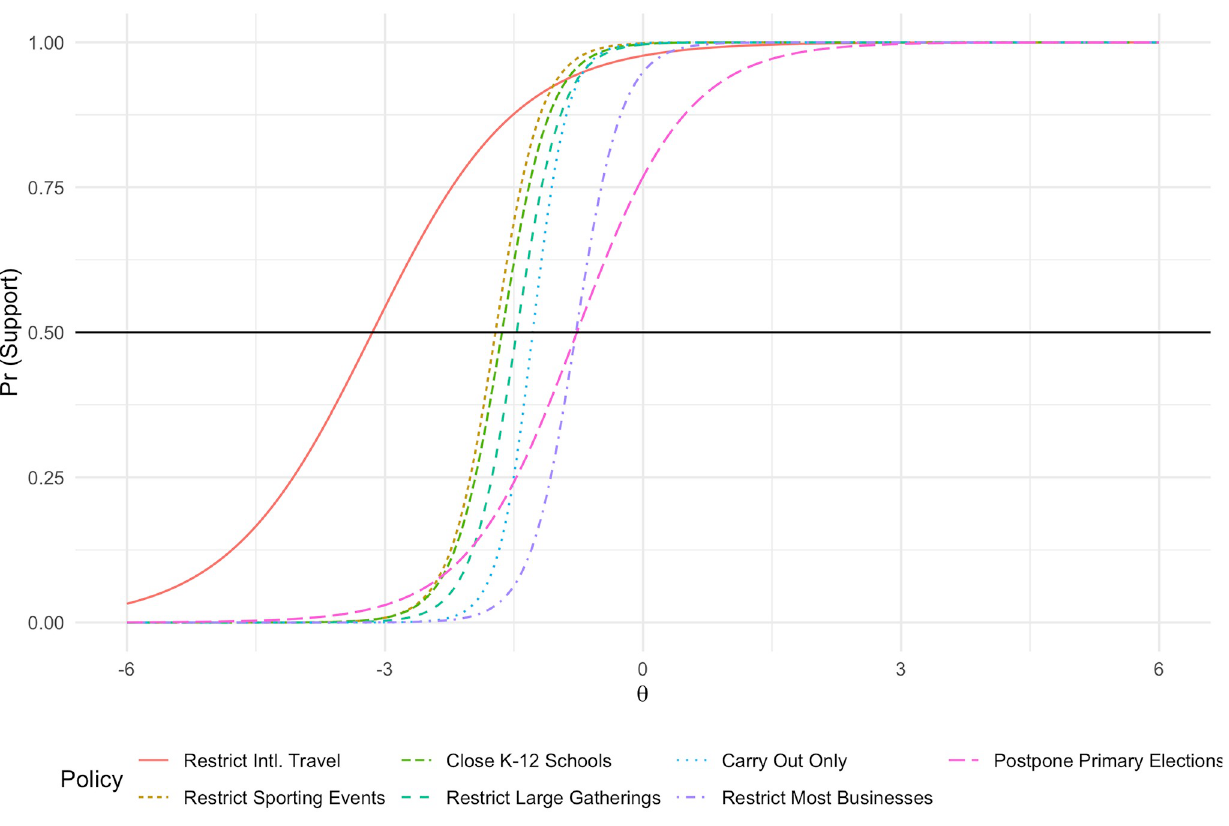
Fig 2. Item characteristic curves of social distancing policy